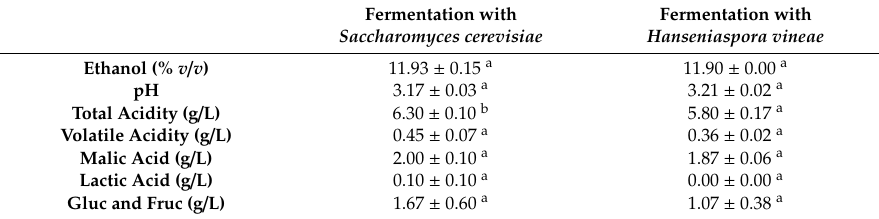
Table 2. Ethanol content (% v / v ), pH, total acidity (g / L) as tartaric acid, volatile acidity as acetic acid (g / L), malic acid (g / L), lactic acid (g / L) and glucose and fructose (g / L) after fermentation process. Mean ± SD for three